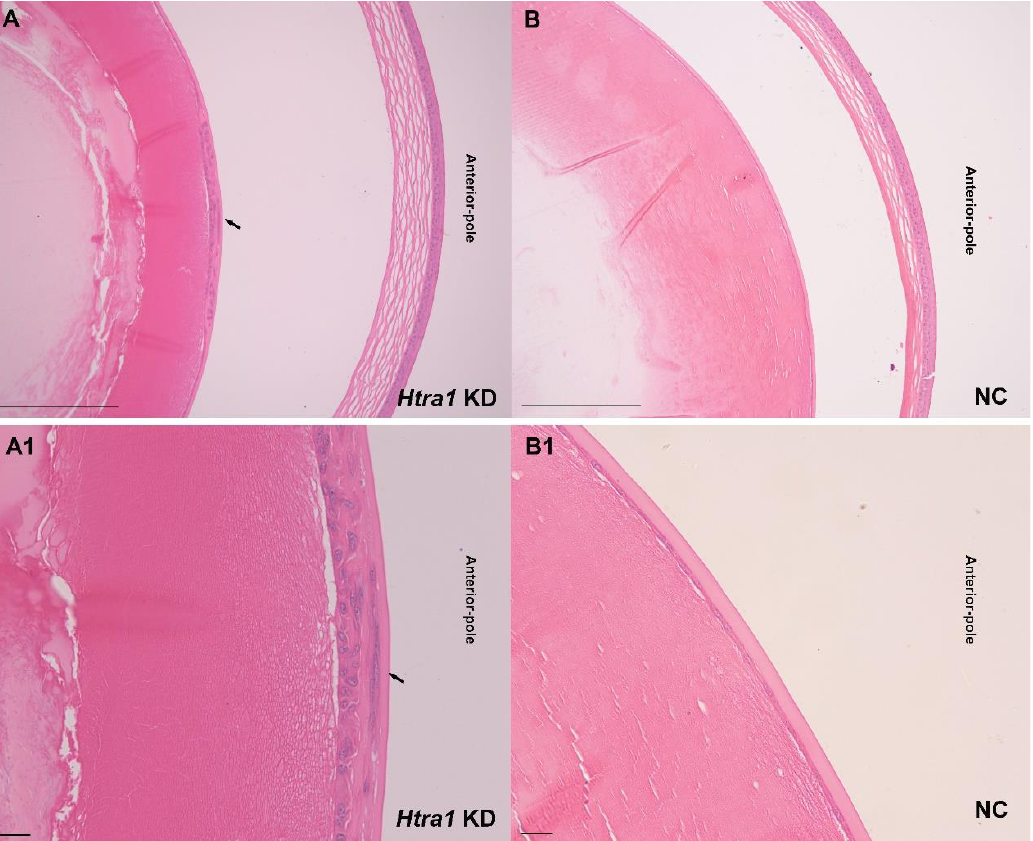
Figure 7. Images of haematoxylin and eosin staining after knocking down HTRA1 by rAAV injection in mouse eyes. Aberrant proliferation and migration of lens epithelial cells were observed in ( A , A1 ) (Arrow). ( A , B ): Scale bar: 200 μm, ( A1 , B1 ): Scale bar: 50 μm. A and A1, as well as B and B1, were images from the same position.